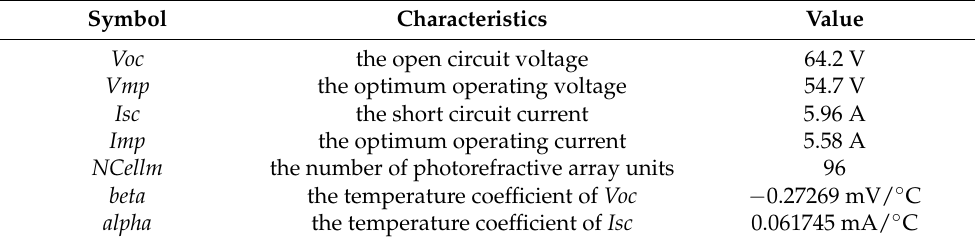
Table 2. Key specifications of the solar panel.